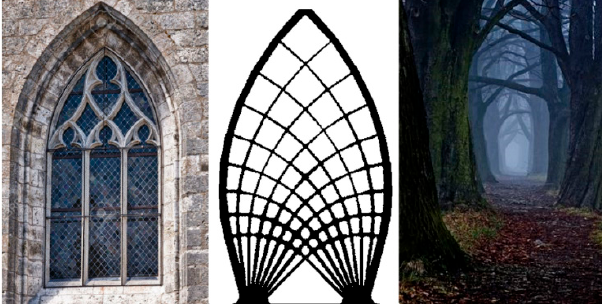
Figure 18. Gothic vaults in the shape of the Michell’s ideal truss contour and the nature-inspired interpretation.